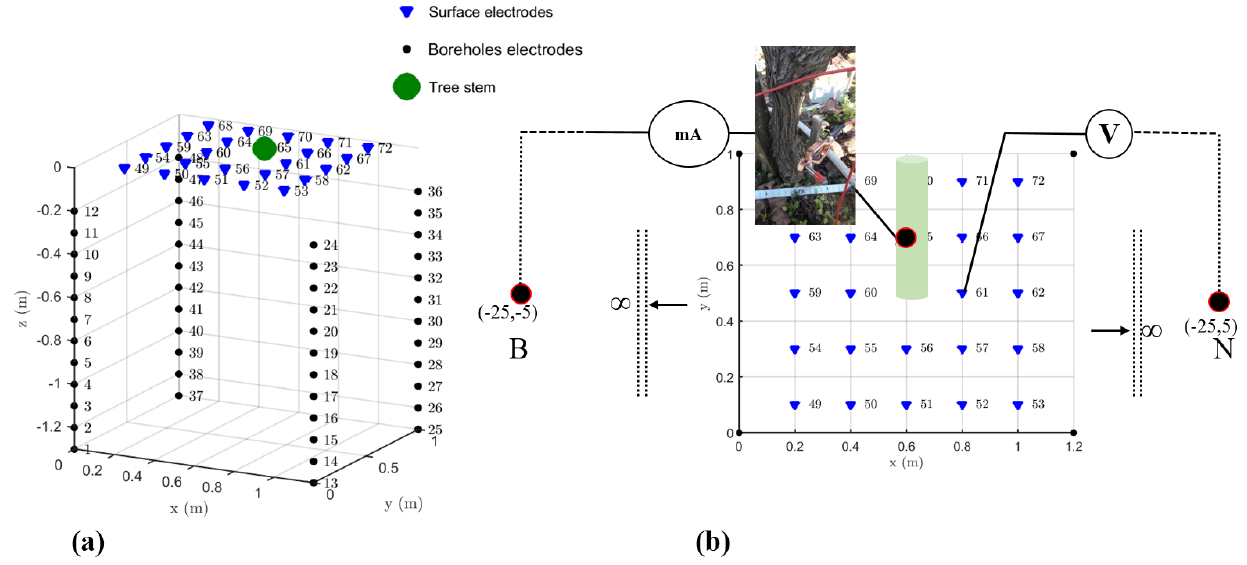
Figure 2. The 3-D schemes of electrical resistivity tomography (ERT) (a) and mise-à-la-masse (MALM) mesh (b) ; B and M are remote electrodes placed 25m apart from the plot.